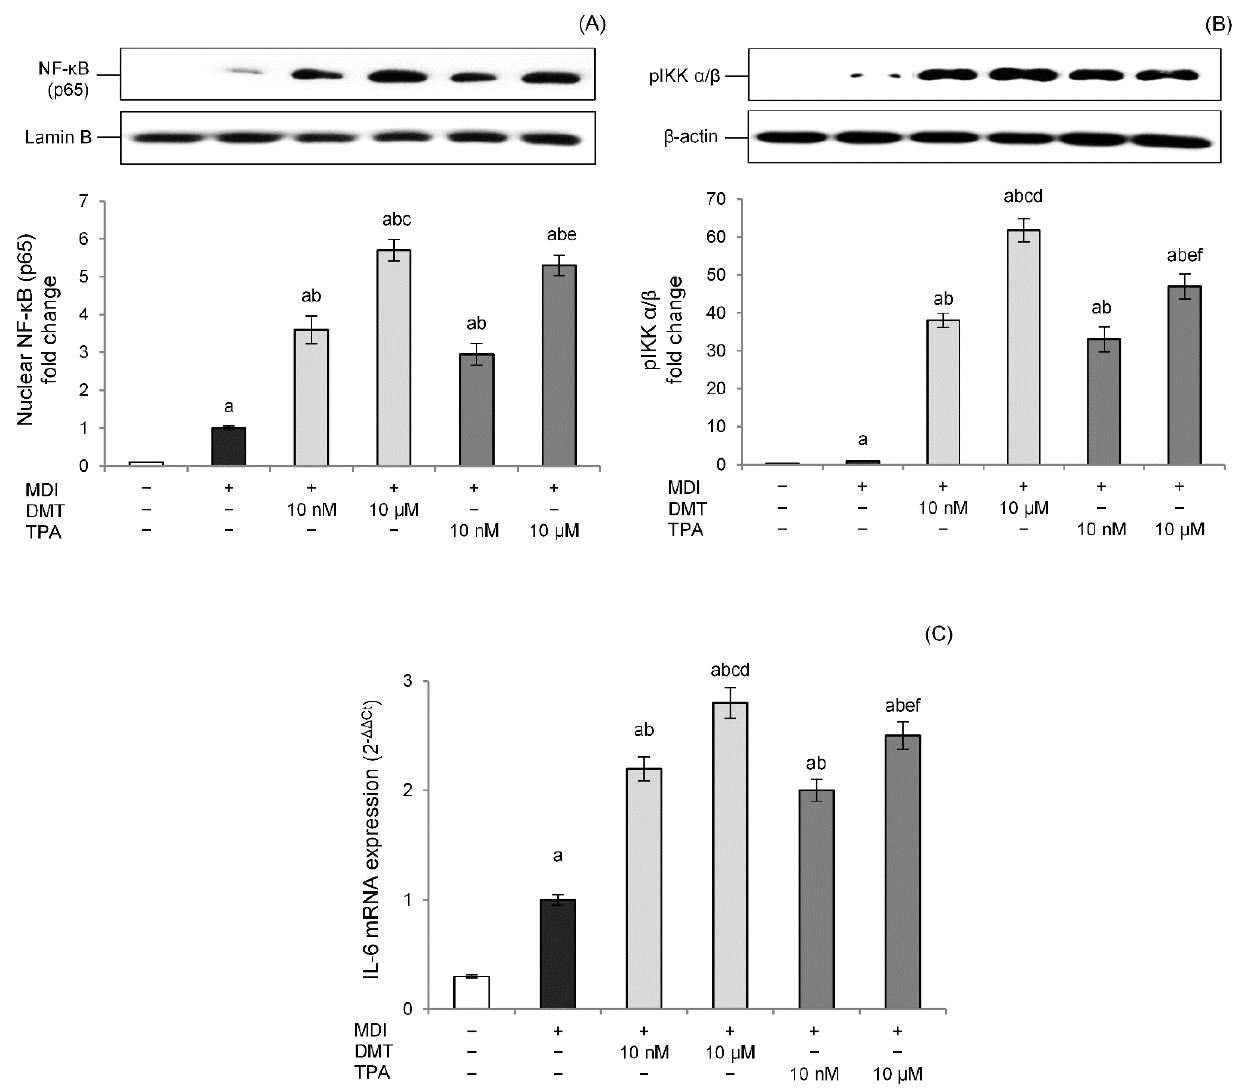
Figure 7. Effects of p-phthalates on nuclear levels of NF- κ B (p65) ( A ), cytosolic levels of p-IKK α / β ( B ), and IL-6 gene expression ( C ). 3T3–L1 preadipocytes were cultured in differentiation